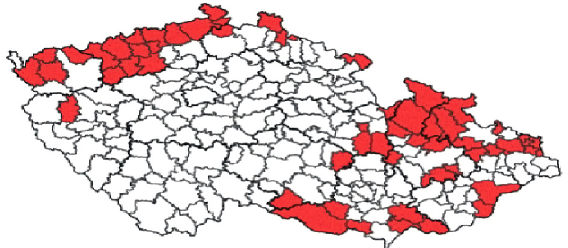
Figure 3. Results of spatial autocorrelation testing in case of Czechia (source: own